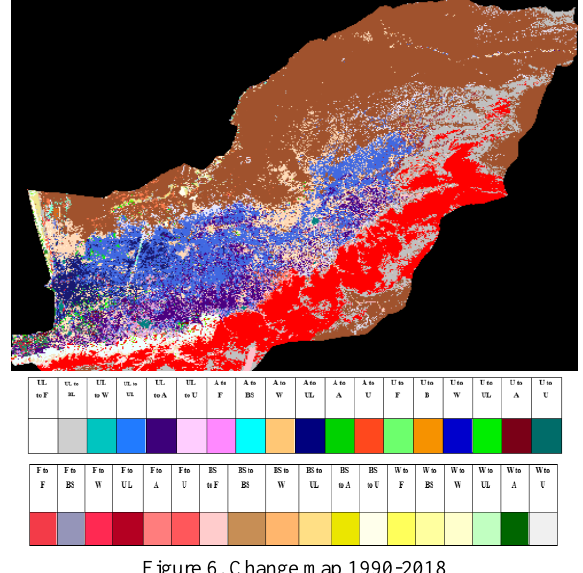
Figure 6. Change map